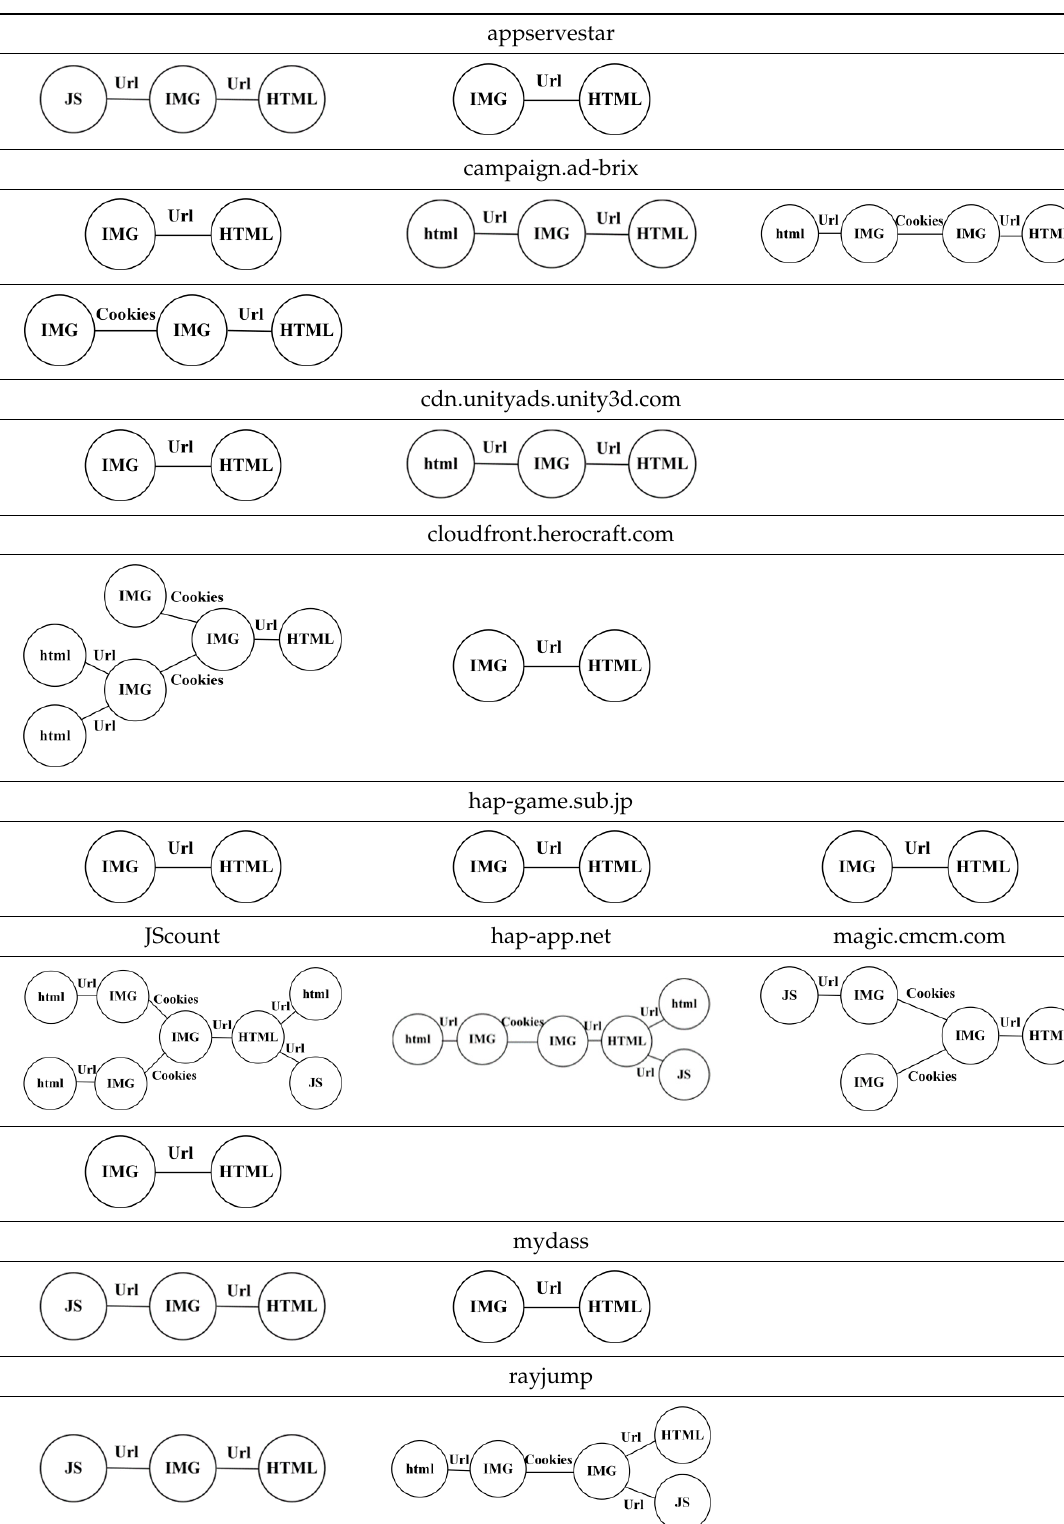
Figure 5. Ad libs’ network behaviors and their graph representations ( a ) MoPub, ( b ) Mmate, ( c ) Hap-game, ( d ) Millennial Media, ( e ) AppLovin.